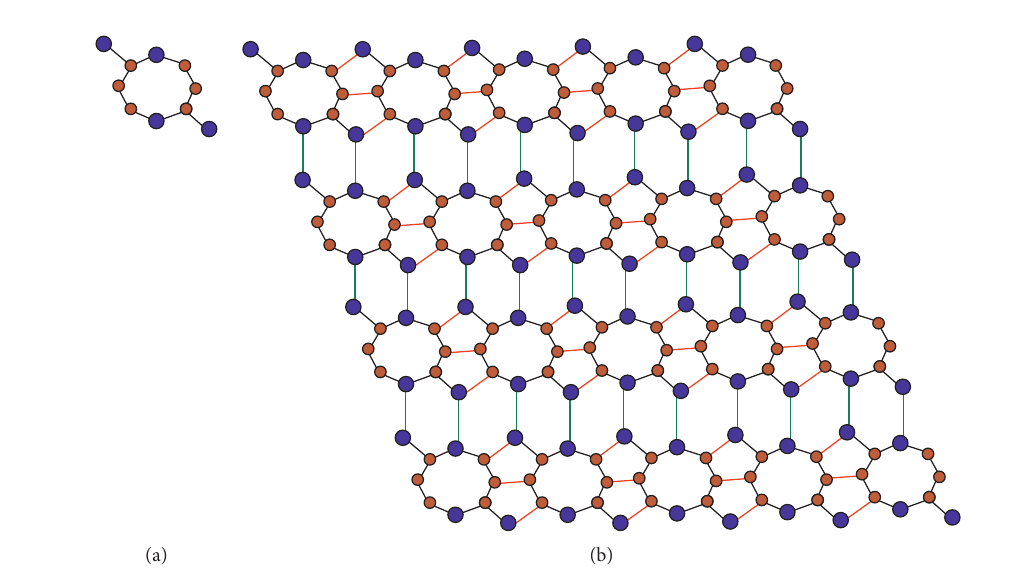
− III [ a, b ]) , and FI ( SiC 3